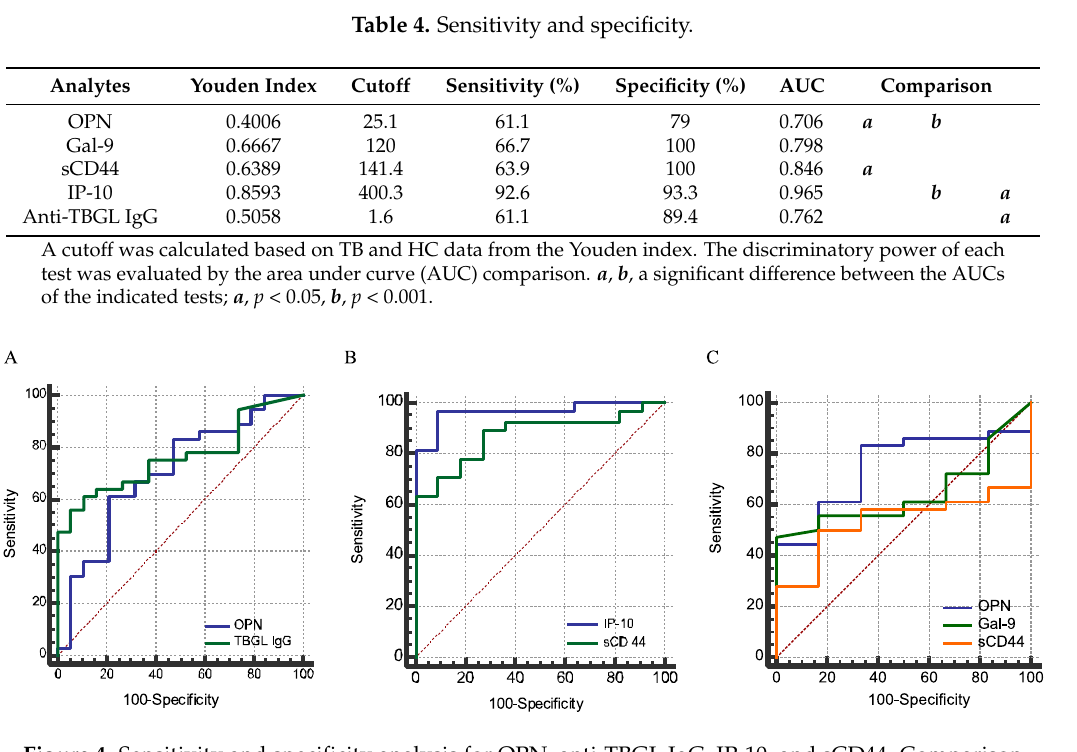
Figure 4. Sensitivity and specificity analysis for OPN, anti-TBGL IgG, IP-10, and sCD44. Comparison between ATB and HCs ( A , B ), no significant difference between the areas under curve (AUC) of OPN and anti-TBGL IgG, IP-10, or sCD44, p > 0.05. Strong discriminatory power of IP-10 and sCD44;